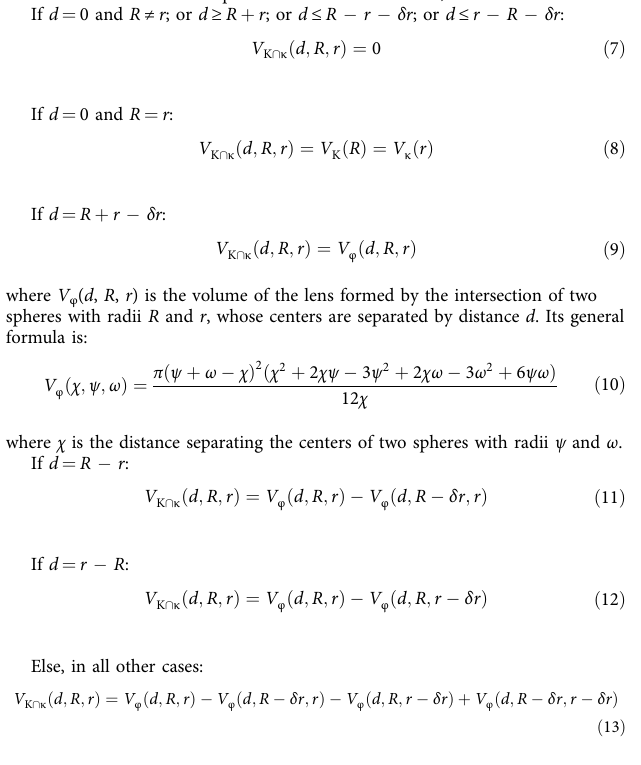
Table 1. The histograms, and their fi ts, are shown in Fig. 3c and Supplementary Figure 7c. We refer the above functions as Fluorescence — Distance — Quencher (FDQ) functions. In this work, we use photochemically-identical TMRM fl uorophores, which exhibit nearly identical PET-mediated bimolecular quenching by Trp (Supplementary Figure 1). Note that, if other fl uorophores are used, their FDQ functions can be scaled by their K SV , to eliminate the differential quenching ef fi ciency variable from the distance measurement. In addition to the C α W α (or d αα ) distance, DEPET optical data can be used to evaluate other distances pertinent to protein structure: for instance the distance between the labeled Cys C α (C α ) and the Trp C β atom — the fi rst atom of the Trp side-chain (W β ). This information is useful to evaluate the orientation of the Trp side-chain with respect to the labeled Cys: if the Trp points towards the labeled Cys, then C α W β <C α W α , and vice versa. To determine C α W β (or d αβ ), new FDQ functions are required. We begin by evaluating the probability to encounter the Trp side-chain (indole) centroid a given distance from W β ( q β ; Supplementary Figure 9a). As expected, this probability density is distributed over a shorter distance than q α (Supplementary Figure 9a). We repeated the exercise of constructing FDQ αα ( X , d αα ) (Eqs. (5 – 13)), now using the q β distribution instead of q α , for each fl uorophore ( X ). Accordingly, we constructed distributions FDQ αβ ( X , d αβ ), which denote the probability to quench fl uorophore X attached to C α as a function of distance d αβ , or C α W β (Supplementary Figure 9b-c). FDQ αβ distributions were also fi t to sums to exponential and Gaussian functions (Eq. (14)); their parameters are listed in Supplementary Table 2. Using a similar strategy, it is possible to construct FDQ βα and FDQ ββ distributions, to correlate PET fl uorescence quenching as a function of distances C β W α and C β W β ,